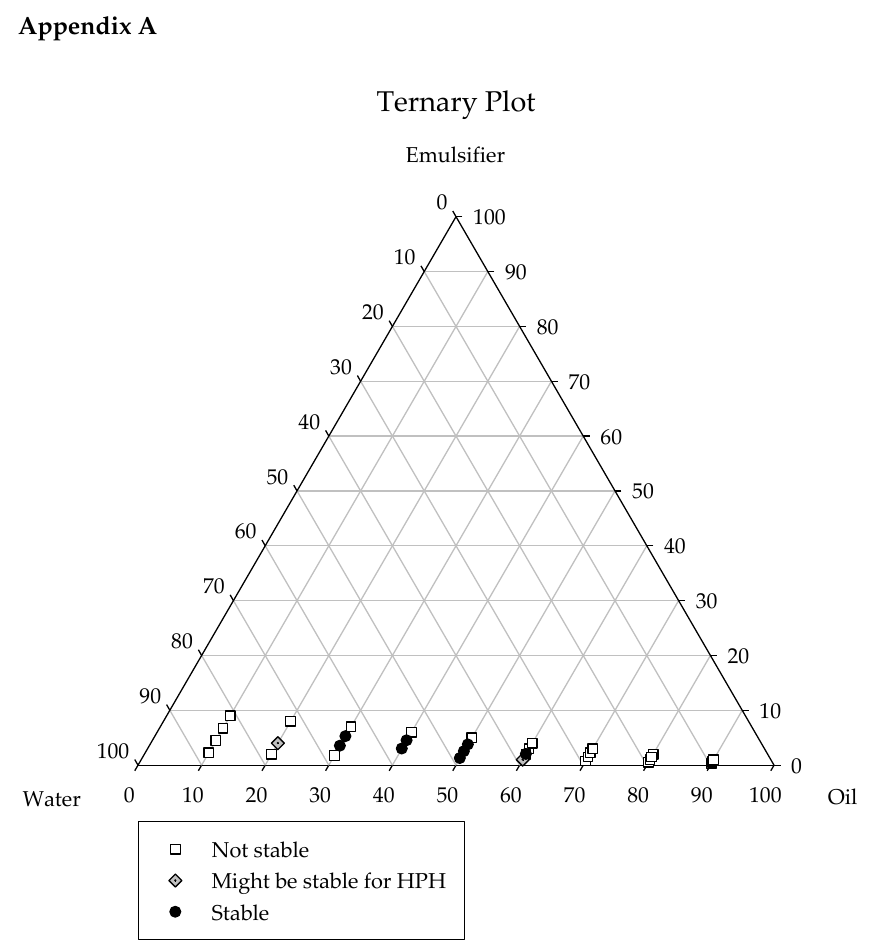
Figure A1. The ternary phase diagram of coarse emulsion.